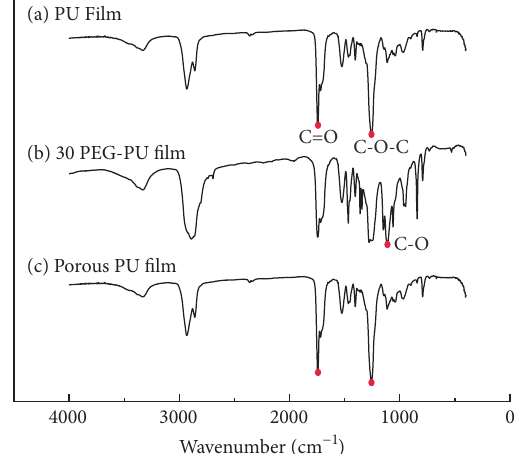
Figure 3: FTIR spectra of a pure PU film (a) and a 30 PEG-PU film before (b) and after (c) PEG extraction.